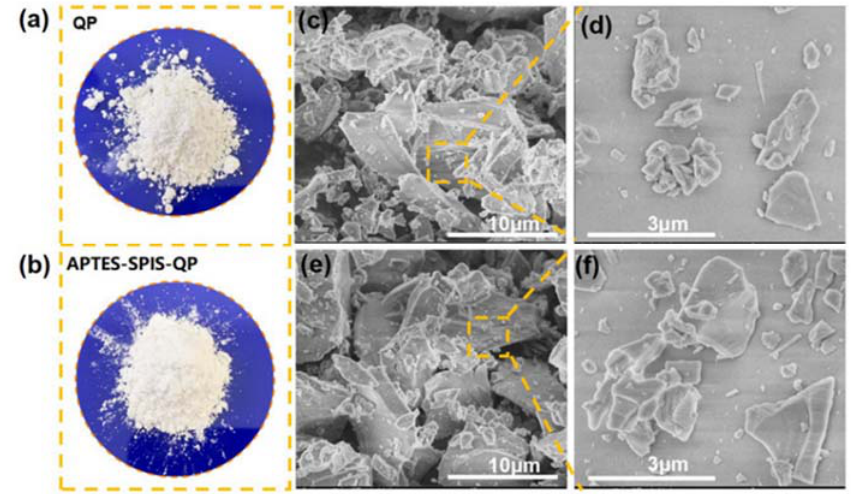
Table 1. D 10 and D 50 of the QP modified by different SCAs.